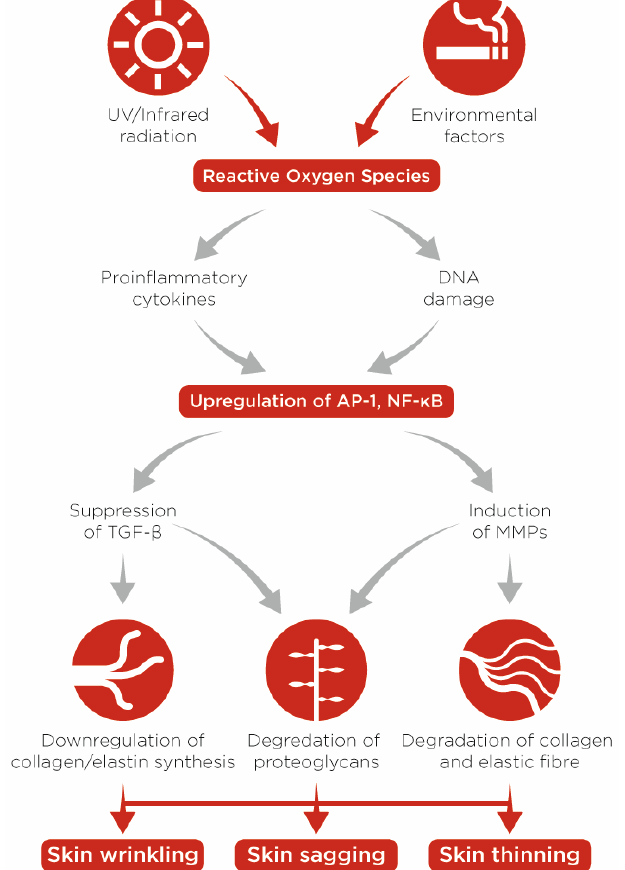
Figure 1. A simplified illustration of the main pathogenetic factors leading to major clinical features of accelerated skin ageing. Abbreviations: AP-1: activator protein 1; NF- κ B: nuclear factor- κ B; TGF- β : transforming growth factor beta; MMPs: matrix metallopeptidases.